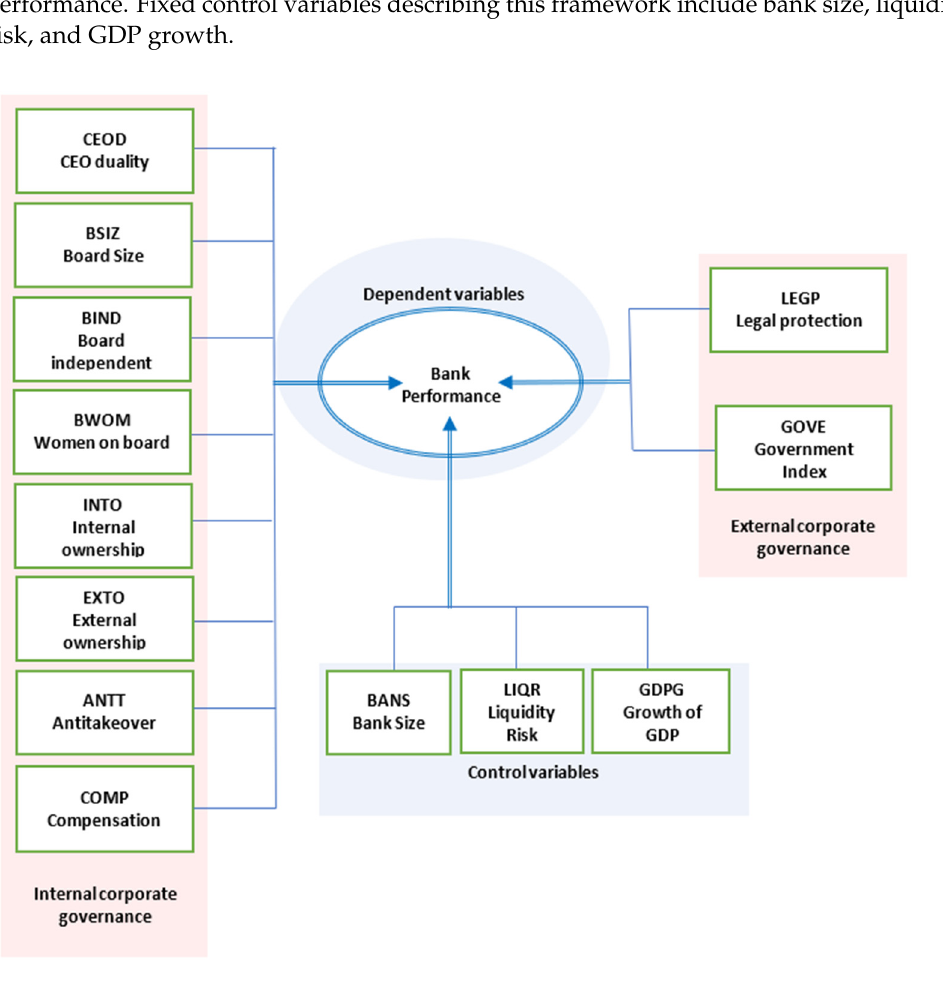
Figure 1. Research